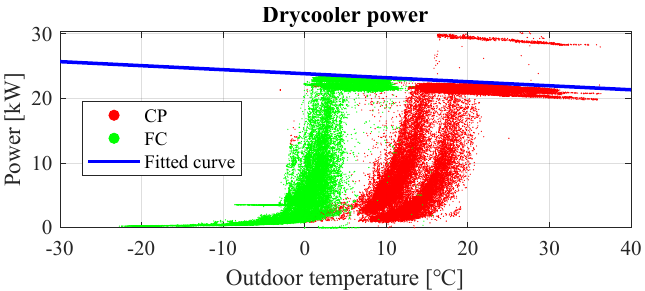
Figure 11. Drycooler